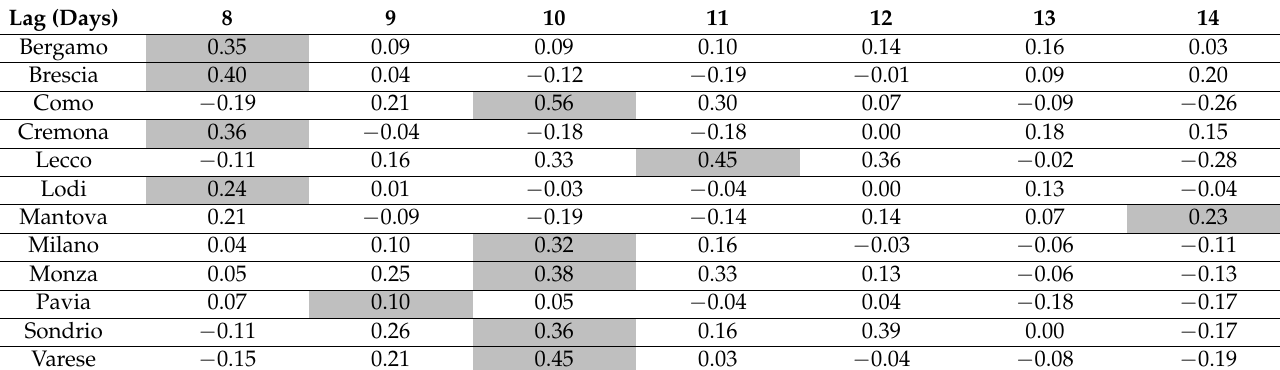
Table 4. Cross-correlation values between the daily incidence of infection and the NAA values obtained varying the lag between the two